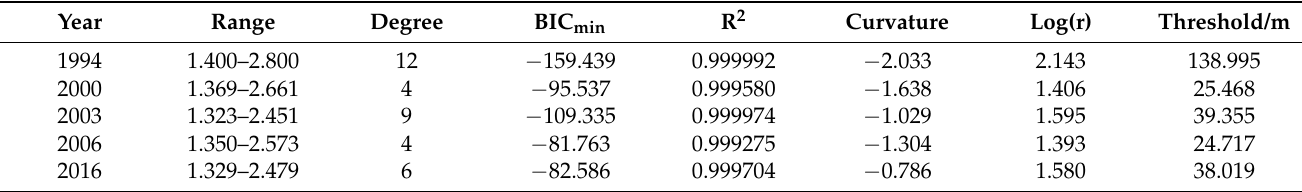
Table 6. Main results of distance threshold calculation.